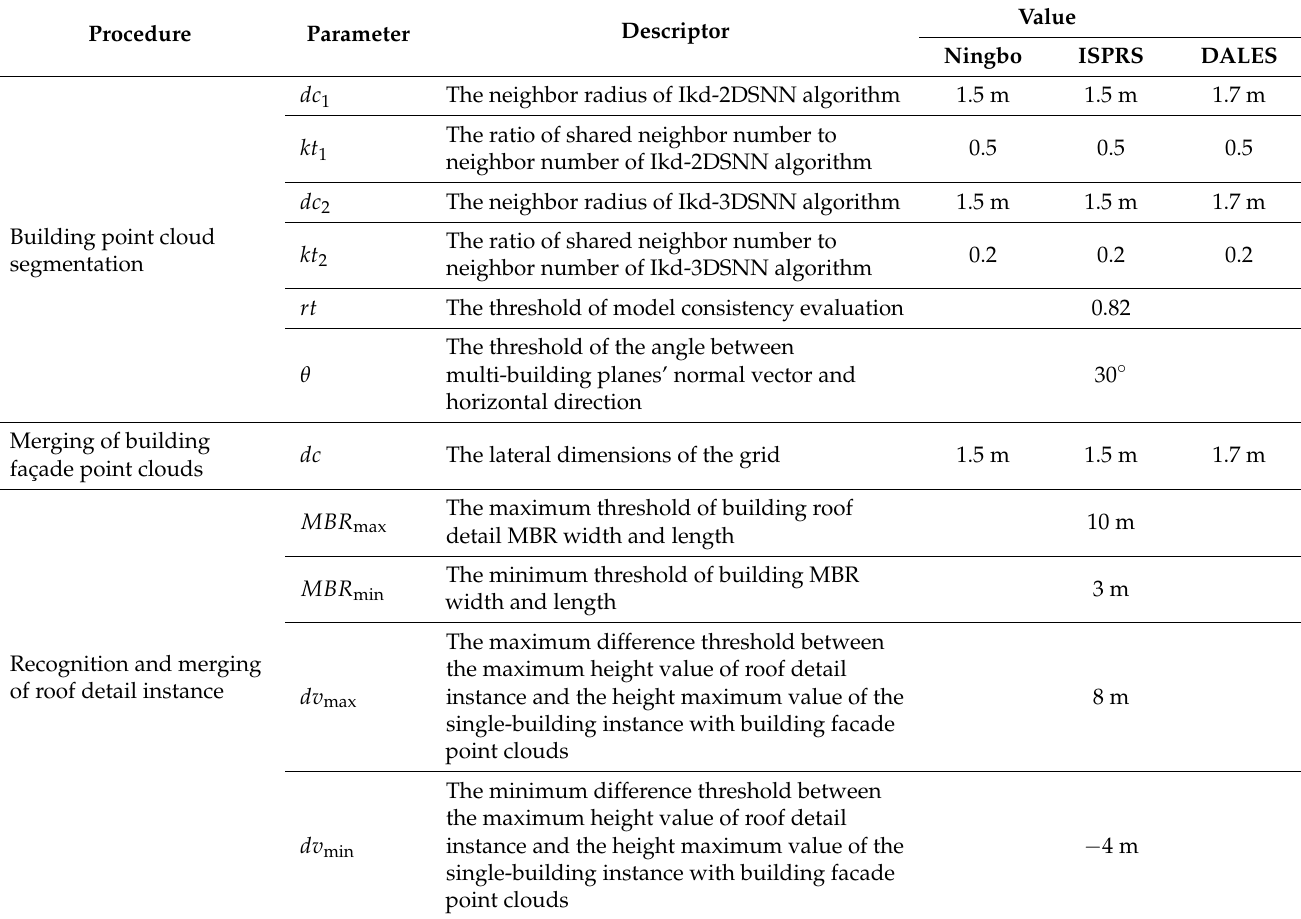
Table 1. Parameters of building instance